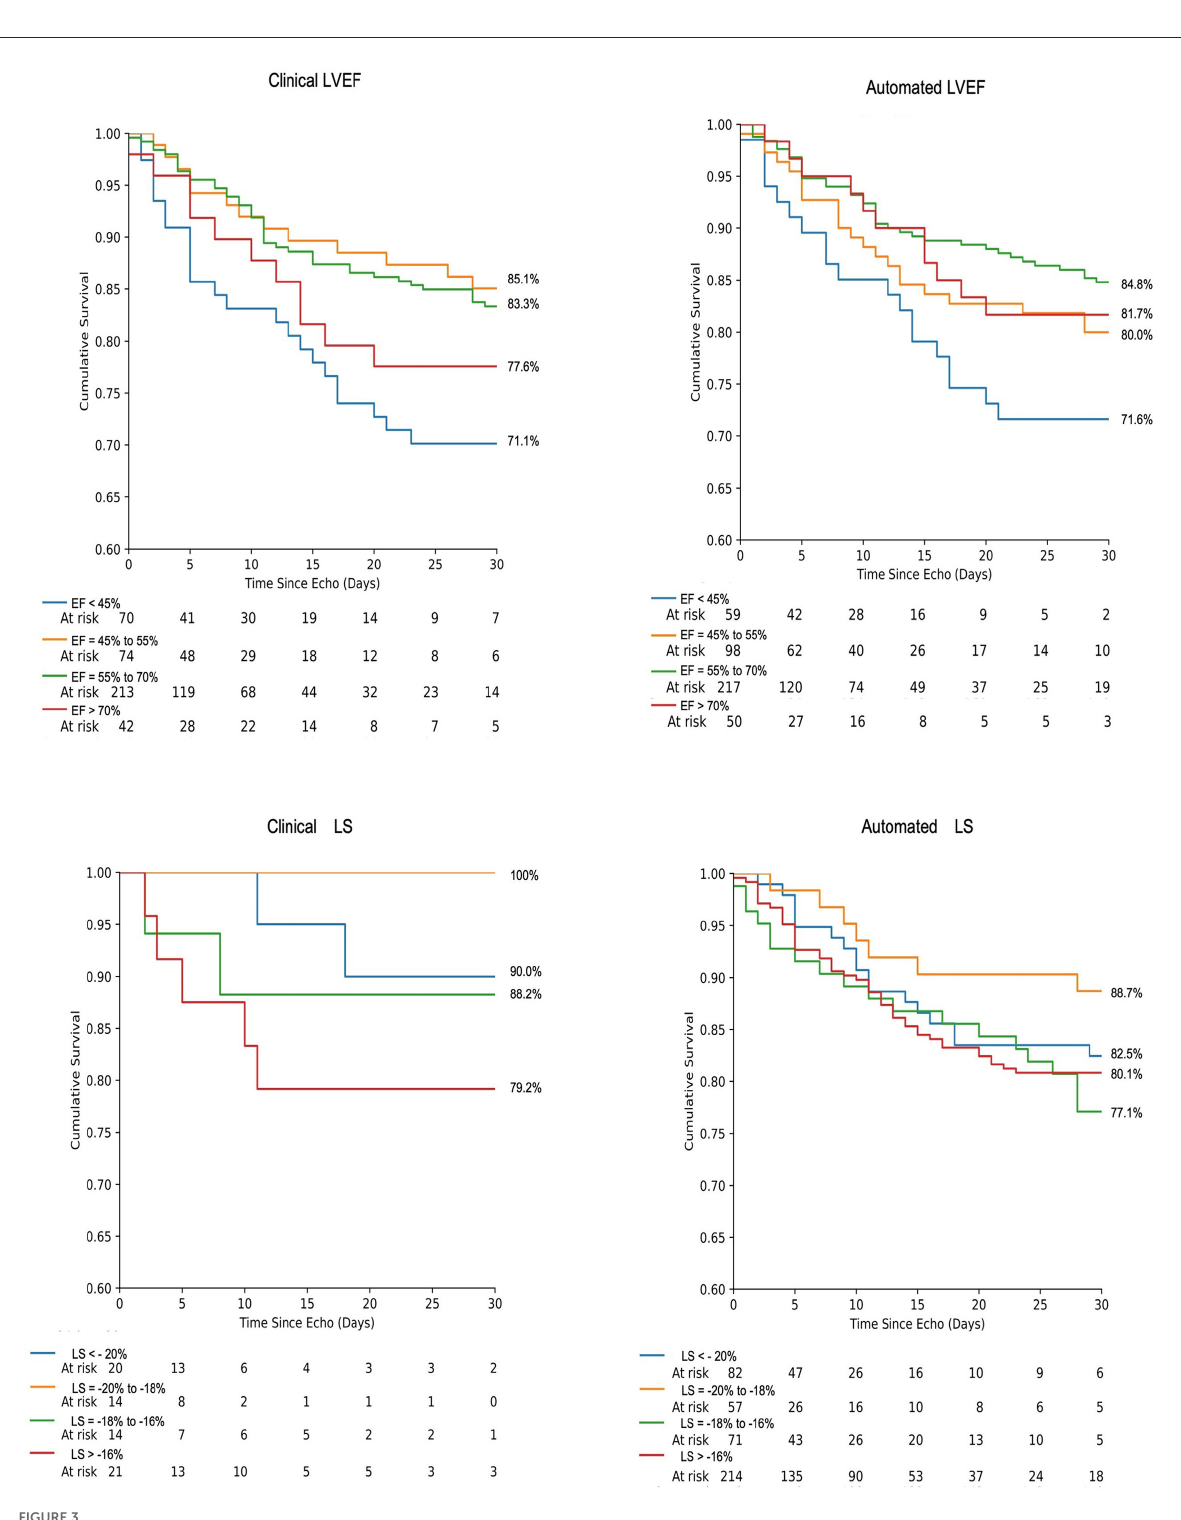
FIGURE3 Kaplan-Meier survival analysis of 30-day mortality using LVEF and LS for both automated and clinically derived values according to strata of systolic dysfunction. Events are right-censored at 30